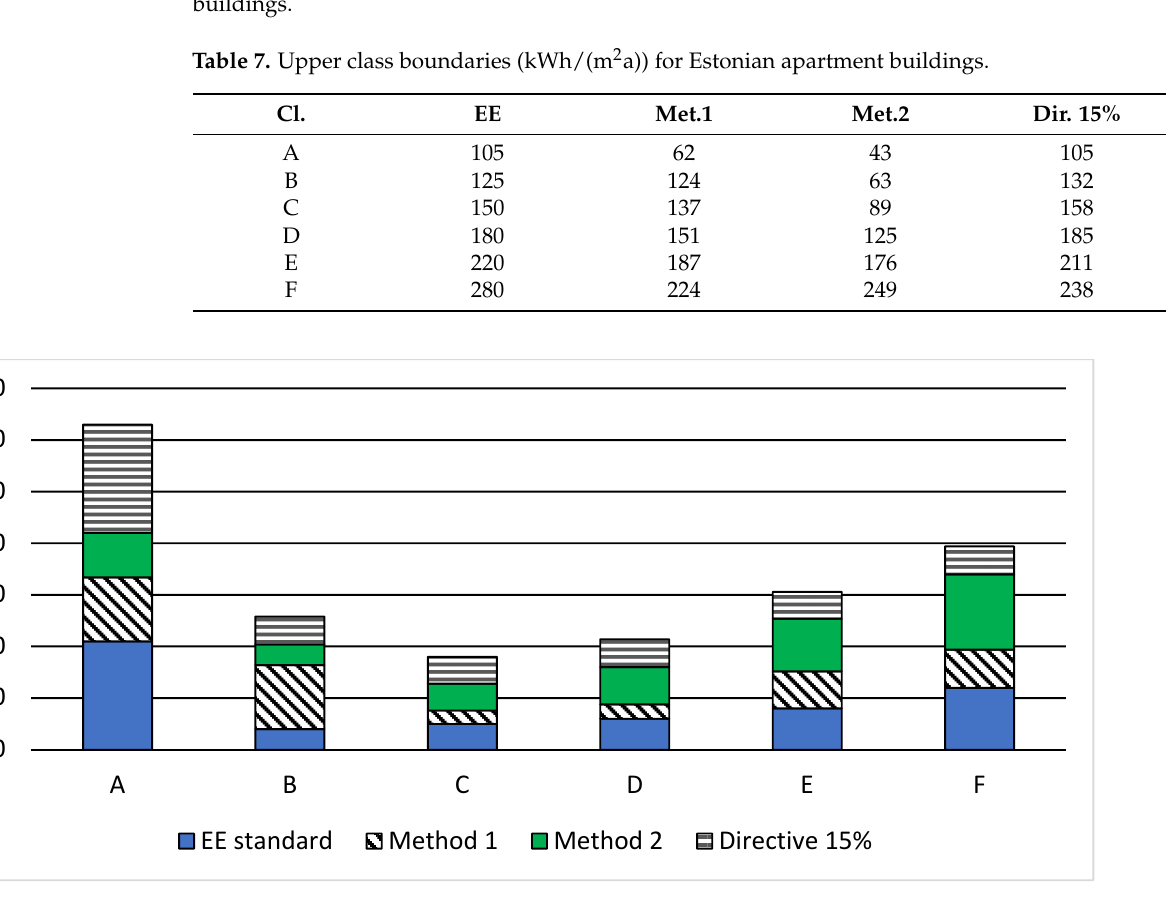
Figure 3 . Energy label classes bandwidths for apartment buildings (kWh/(m2a)). Figure 3. Energy label classes bandwidths for apartment buildings